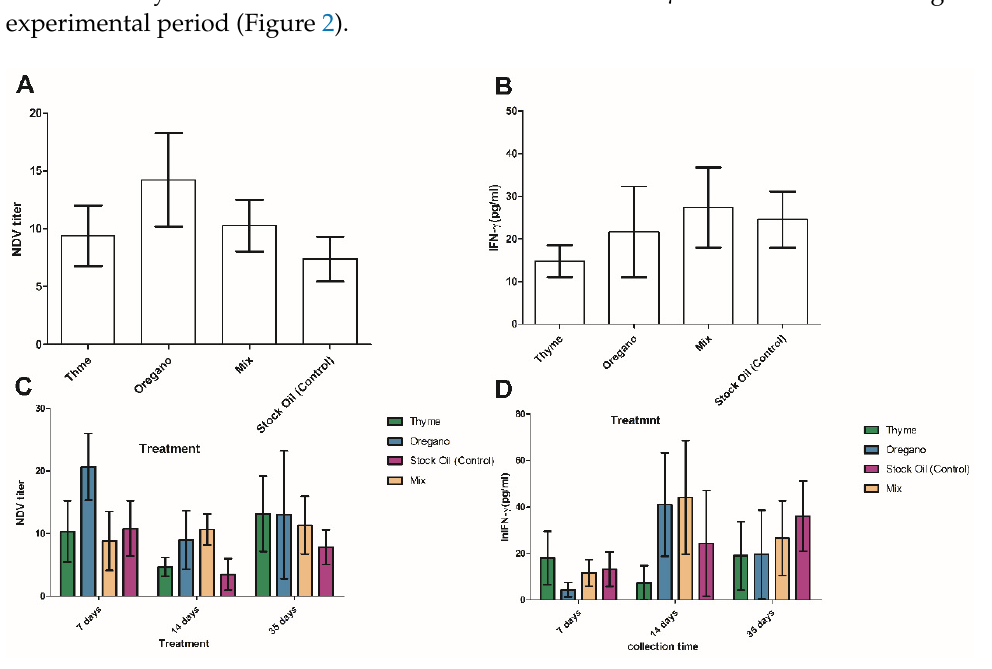
Figure 2. Cumulative changes in NDV Ab titer ( A ) and IFN- γ ( B ) and timely changes in NDV Ab titer ( C ) and IFN- γ ( D ) of the treated groups (at three time points: eight birds in each group at 7, 14, and 35 days). p > 0.05.